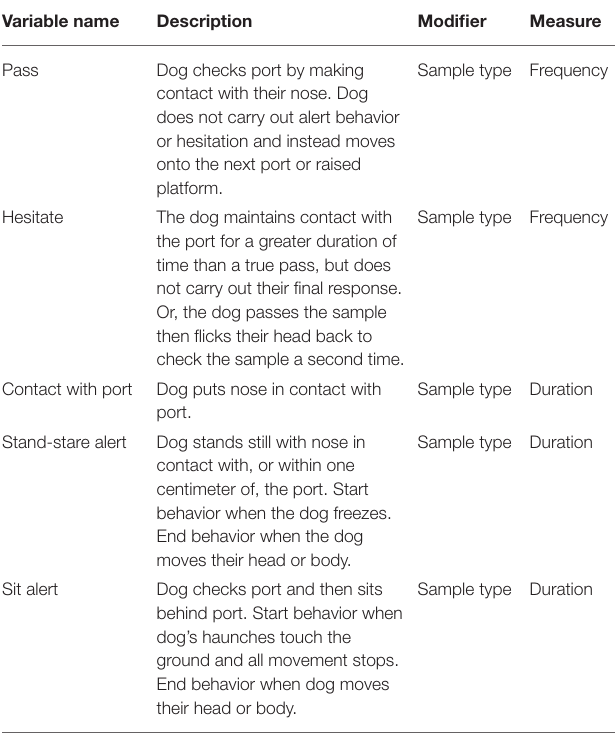
TABLE 1 | Behavioral ethogram used to code the